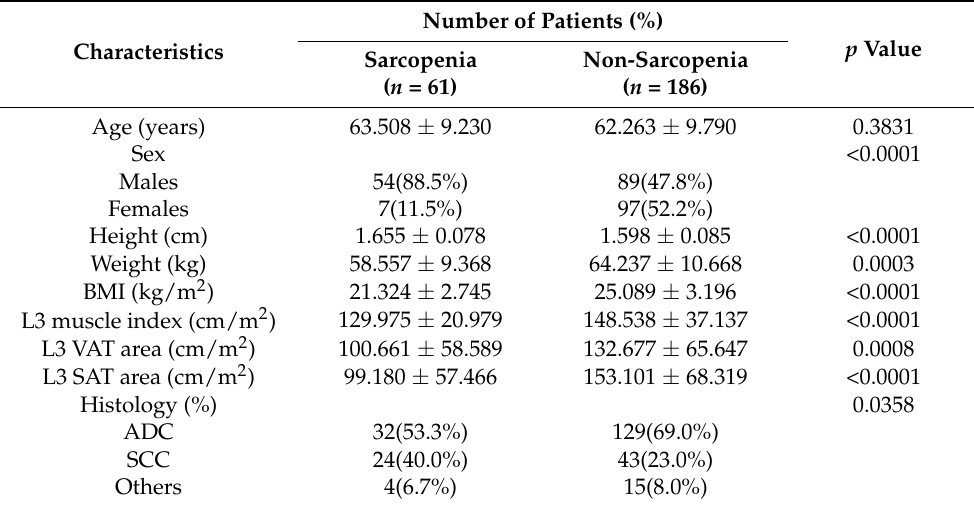
Table 2. Characteristics of the patients in the sarcopenia and non-sarcopenia groups and comparisons between the